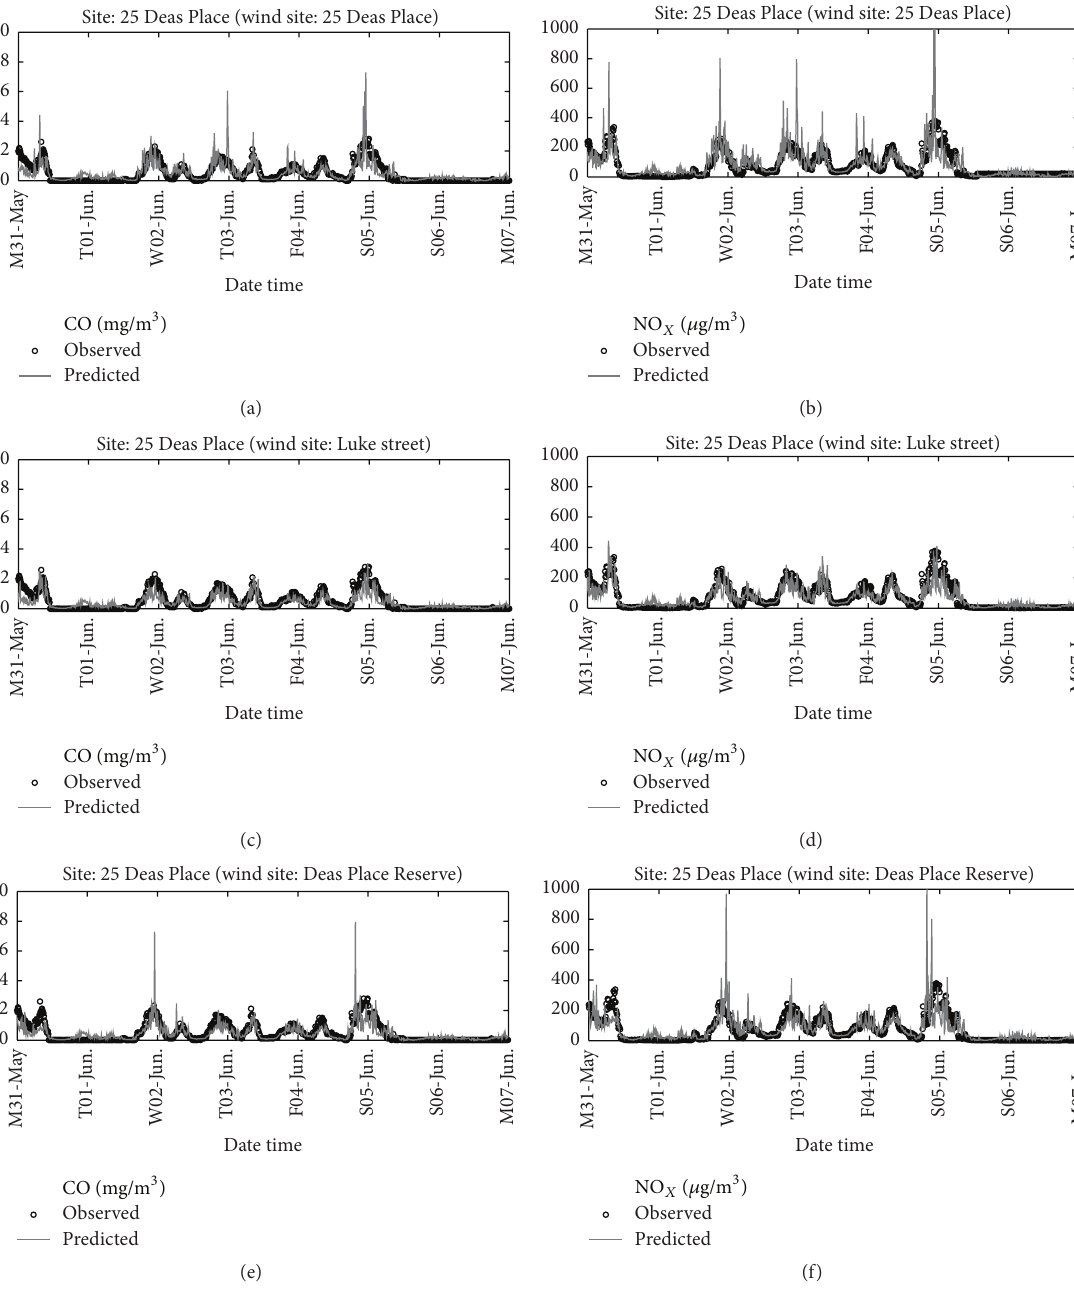
Figure 4: Examples of one-week time series of observed and predicted ten-minute average CO and NO 𝑋 concentrations at 25DP using wind data from 25DP, LS, and DPR, respectively. The results suggest that the best model performance is achieved using data from LS (the “open”